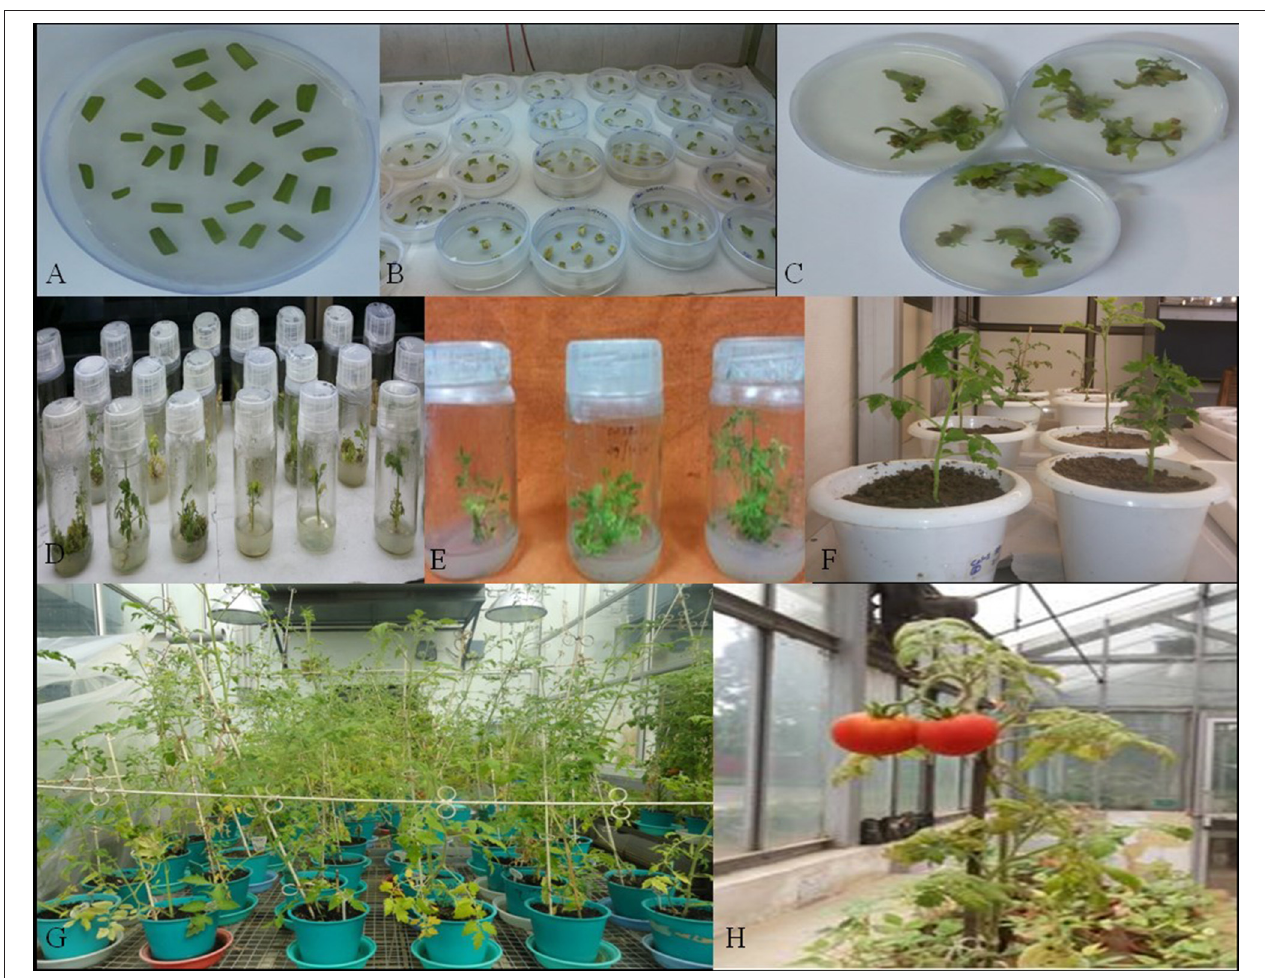
FIGURE 3 | Different stages in the development in transgenic tomato plants carrying Mi-col-1 and Lemmi-5 dsRNAs independently. (A) Tomato leaf explants in the precultivation medium, (B) Explants in the selection medium, (C) Development of callus in the selection medium, (D) Development of shoots in the shooting medium, (E) Development of roots in the rooting medium, (F) Putative transgenics in the pots for hardening, (G) Further growth and hardening of putative transgenic plants in the National Phytotron Facility, (H) Development of fruits in the putative transgenic plants.